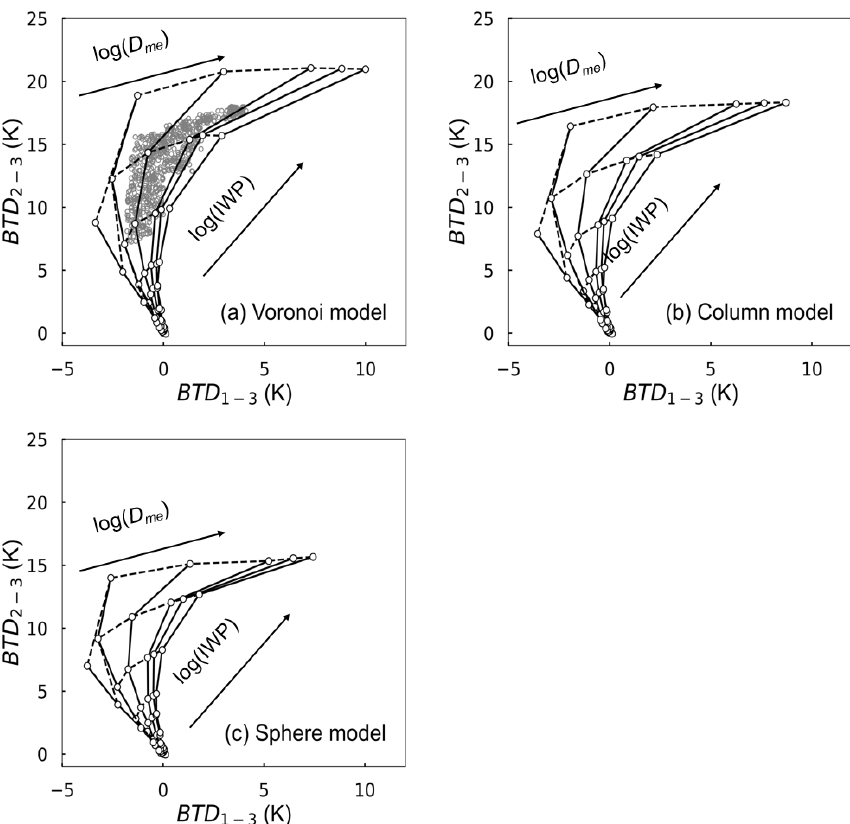
Figure 9. The LUT of BTD 2–3 and BTD 1–3 for the (a) Voronoi, (b) column, and (c) sphere ICS models varying with the logarithm of IWP and D me . Grey dots in circles represent the randomly generated 2000 test data from the RSTAR model.